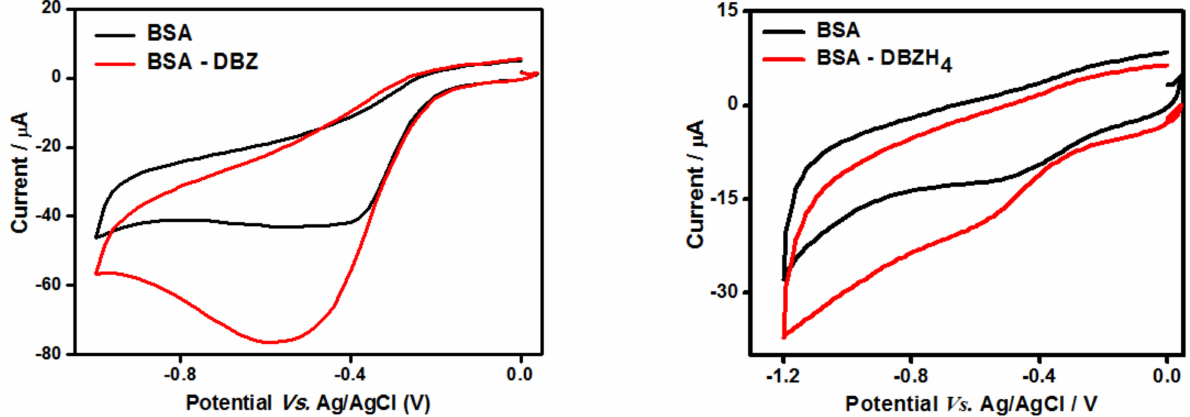
Figure 5. Cyclic voltammogram of BSA in the absence and presence of DBZ and DBZH 4